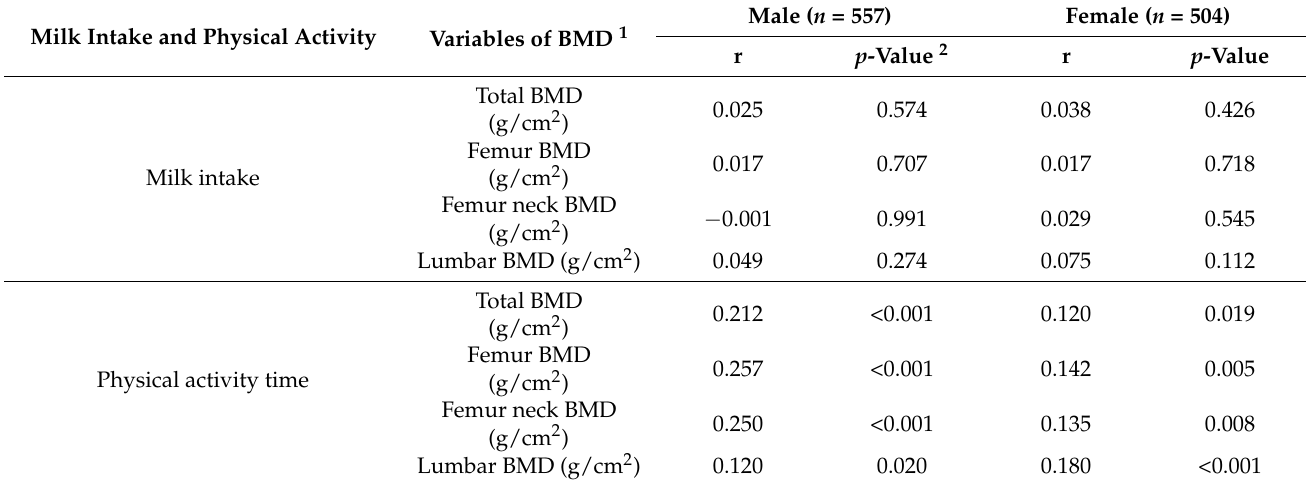
Table 4. Relationships of bone mineral density with milk intake and physical activity.